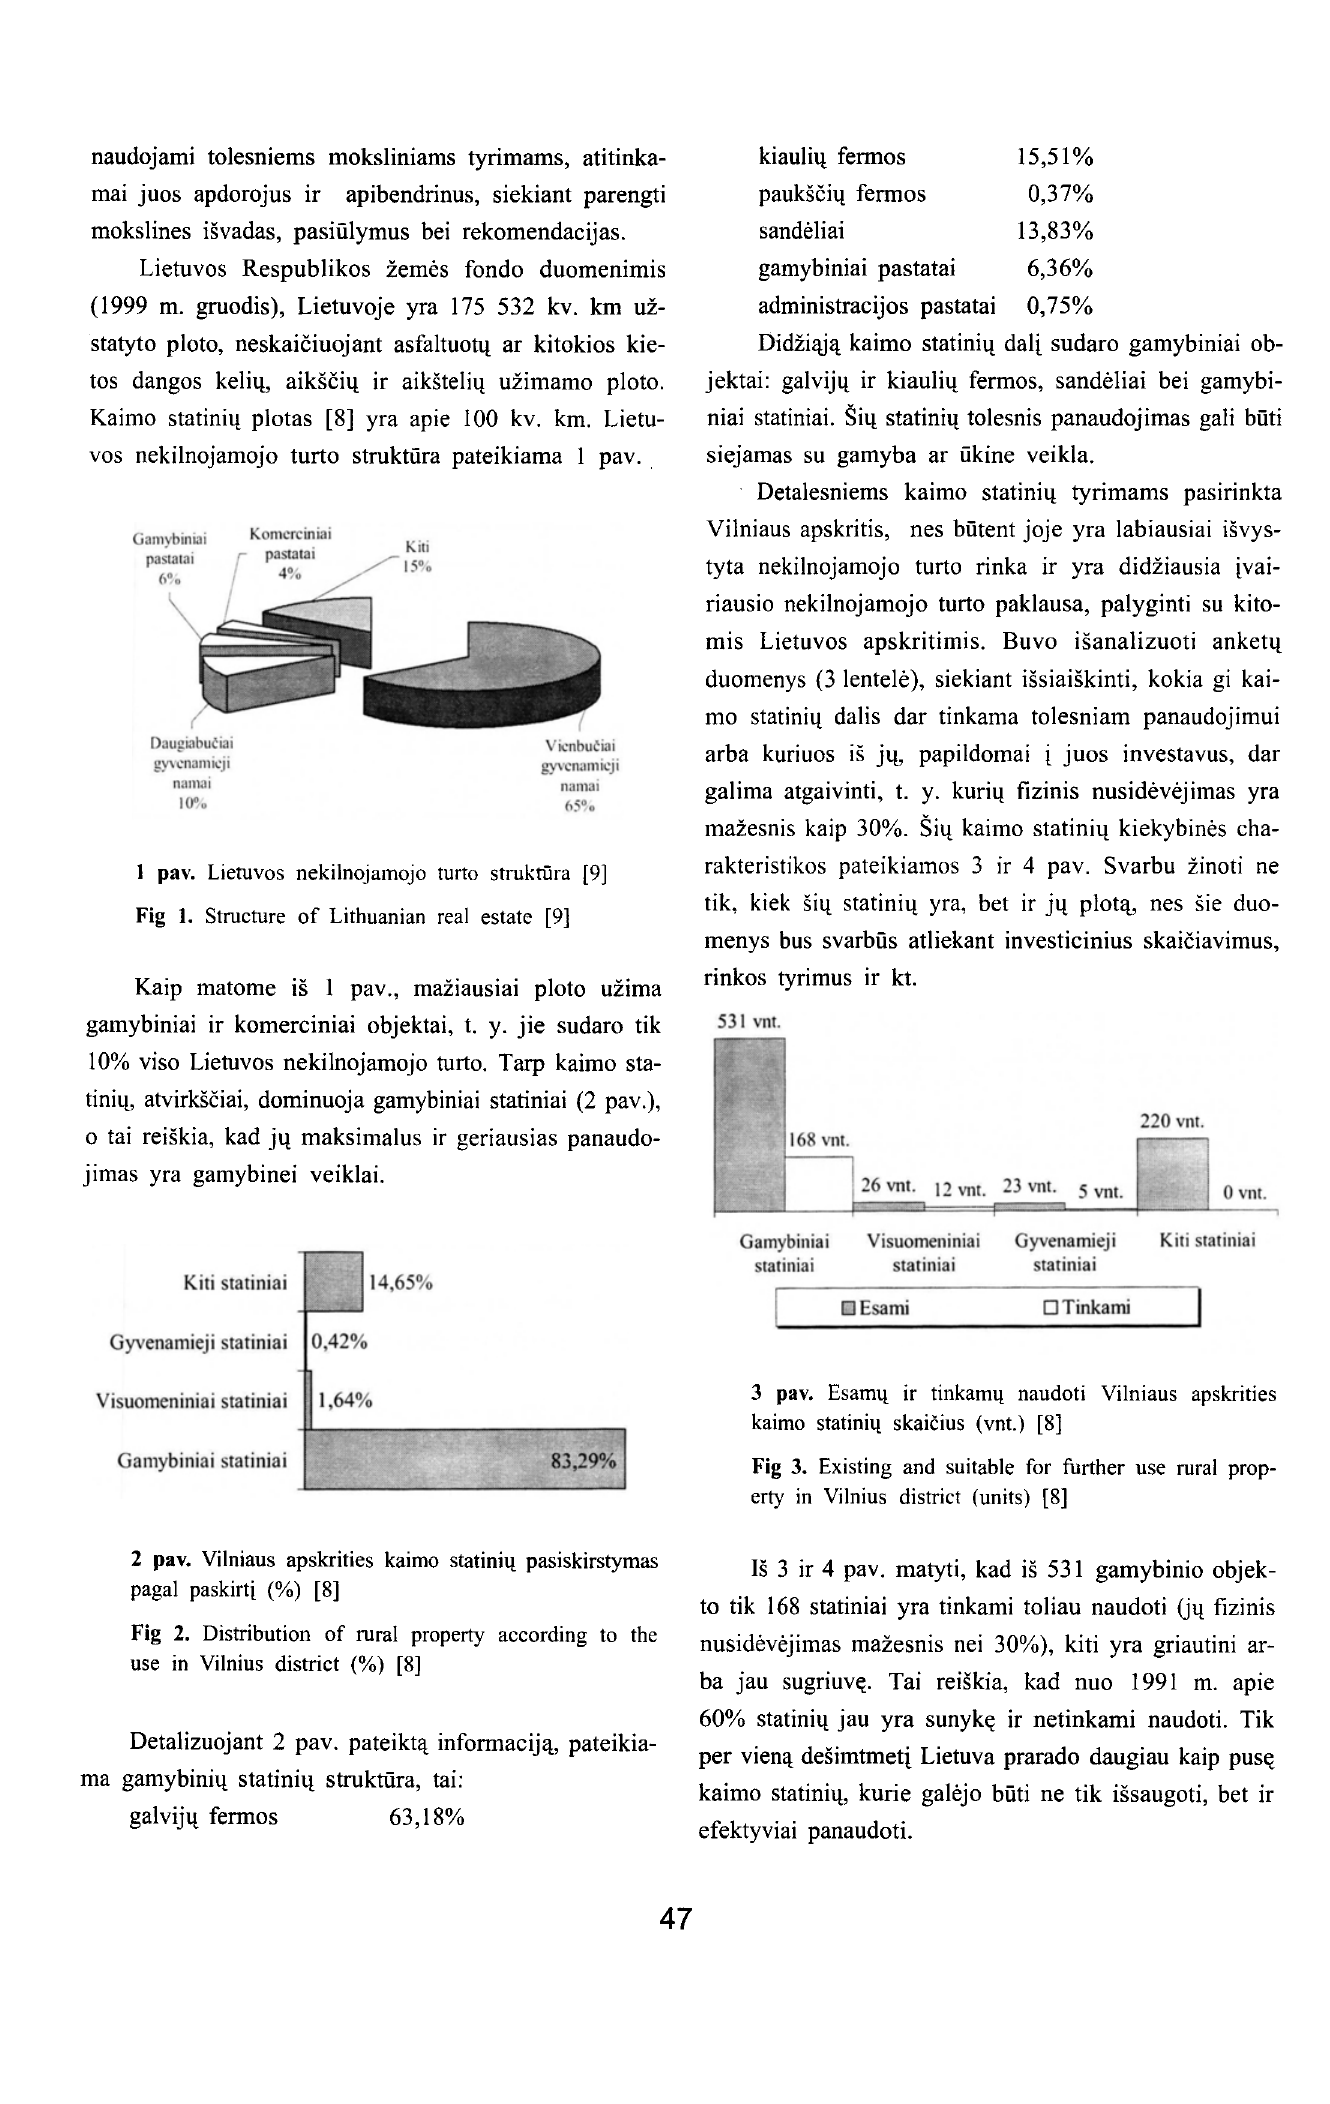
Fig 2. Distribution of rural property according to the use in Vilnius district (%) [8]